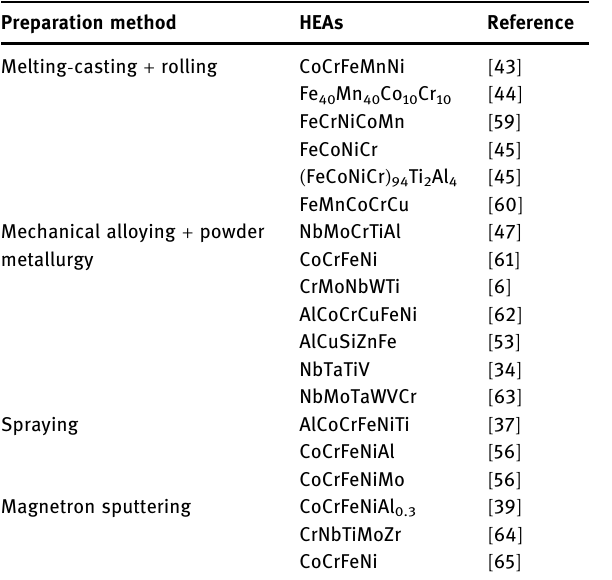
Table 1: Summary of preparation methods of di ff erent HEAs Preparation